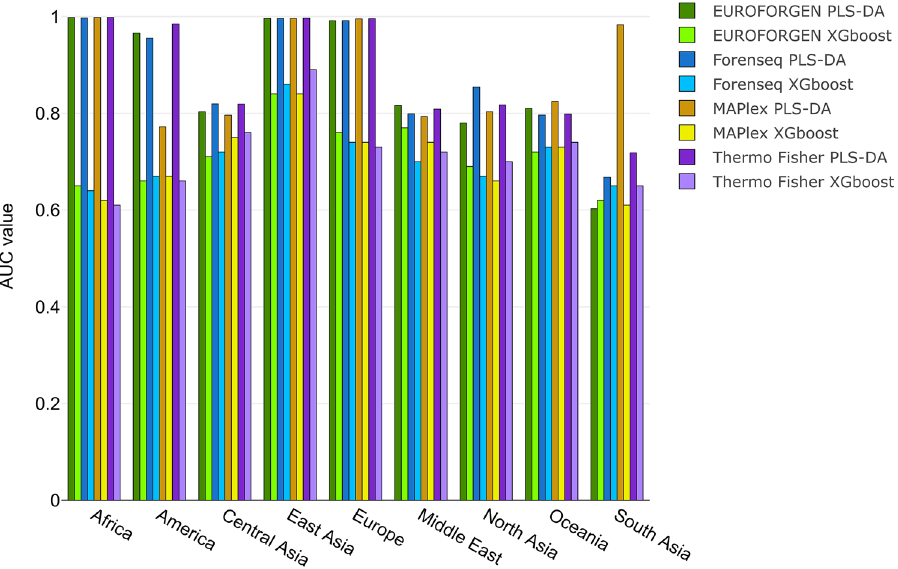
Figure 4. Comparison between AUC values of different populations obtained from PLS-DA and XGBoost model at inter-continental level considering Asian divided into regions.